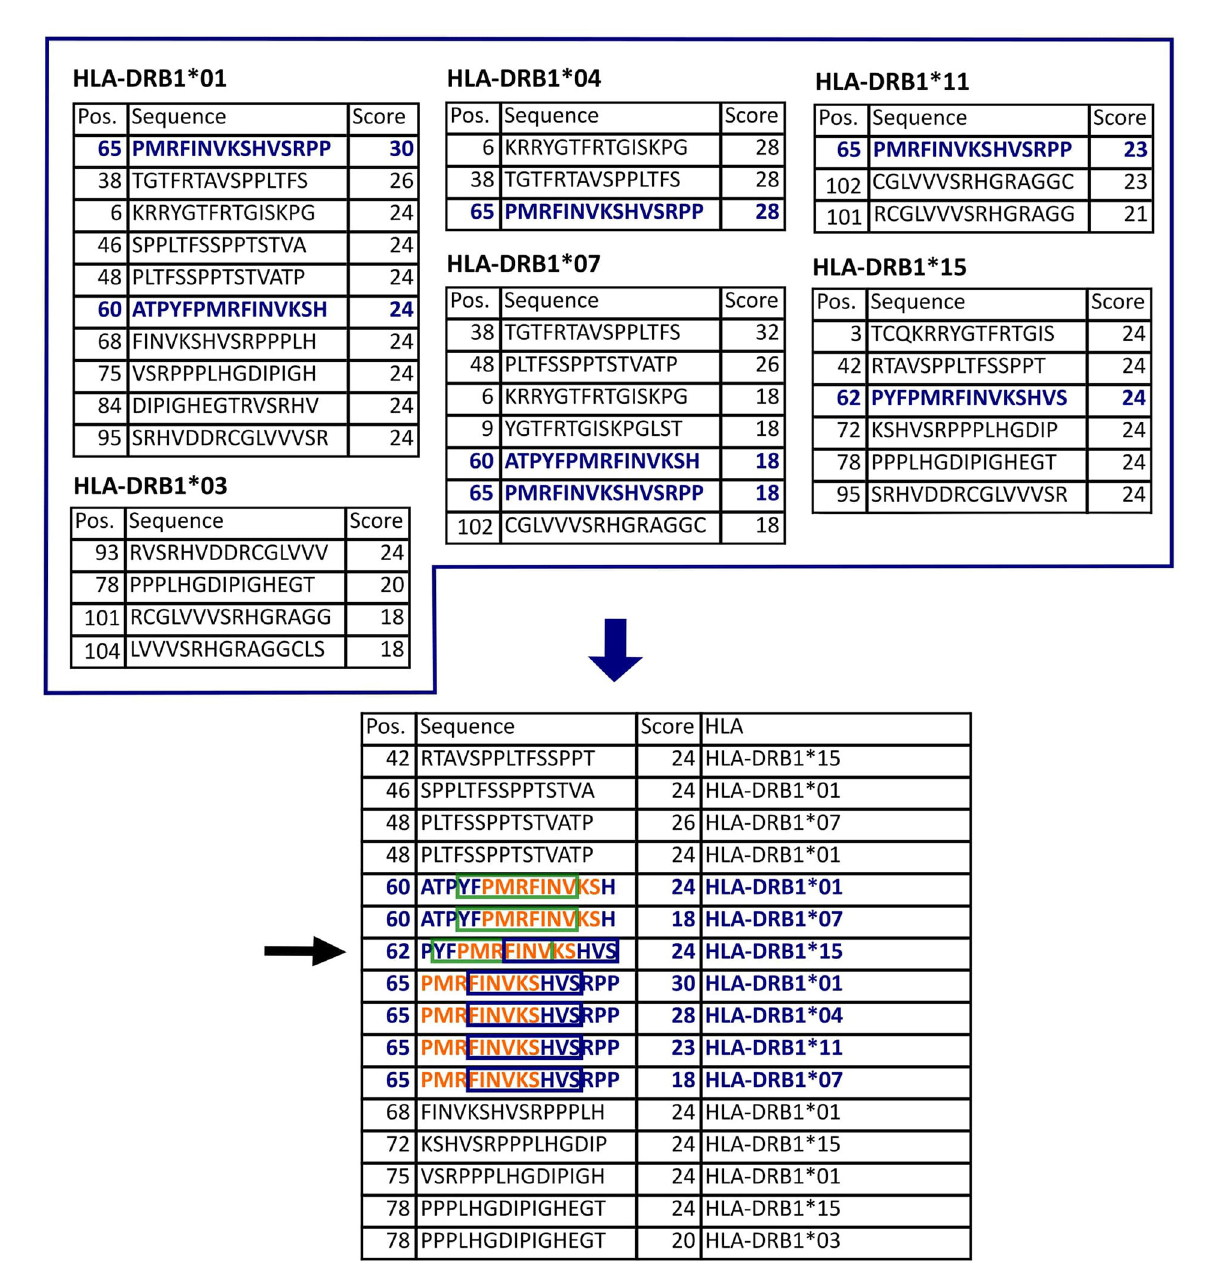
FIGURE 2 | Epitope selection example for protein US4. The upper tables list the 2% highest scored peptides for each of the HLA allotypes of interest. This protein is 119 aa long. Thus, there are 105 possible 15-mers. In this case, the 2% highest scores equal to 2.1, so the three highest scored peptides were selected (all peptides with the smallest selected score value were considered, see HLA-DRB1*01,03,07,15). The lower table lists all selected peptides sorted by their position in the protein. The nine-aa-long binding-core (orange letters, green box, and blue box) is essential for the stable binding of a peptide to an HLA molecule. The binding core of the selected epitope candidate could be shifted three positions either to the N- or to the C-terminus. Accordingly, the peptide 62-76 (black arrow) potentially binds to fi ve different HLA allotypes (in blue) since it contains the binding cores of seven peptides that are predicted binders to these HLA